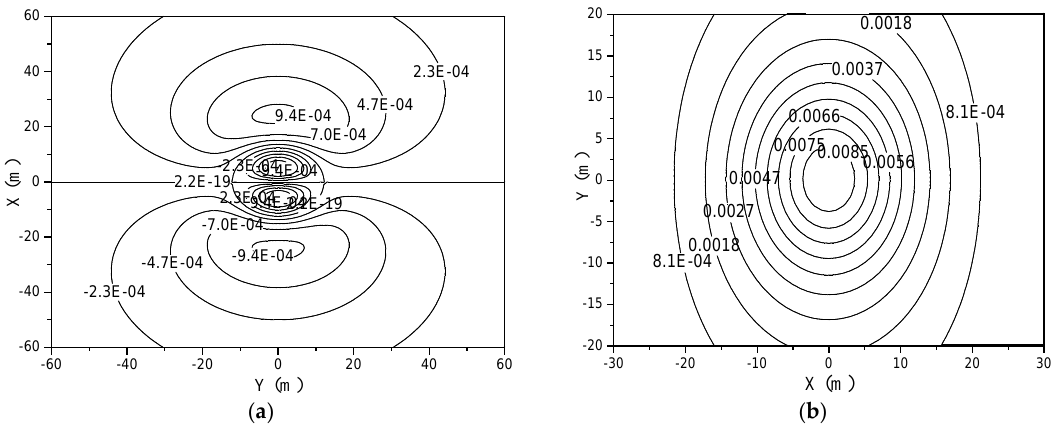
Figure 10. Ground movements caused by f d : ( a ) Settlement; ( b ) Horizontal displacement.